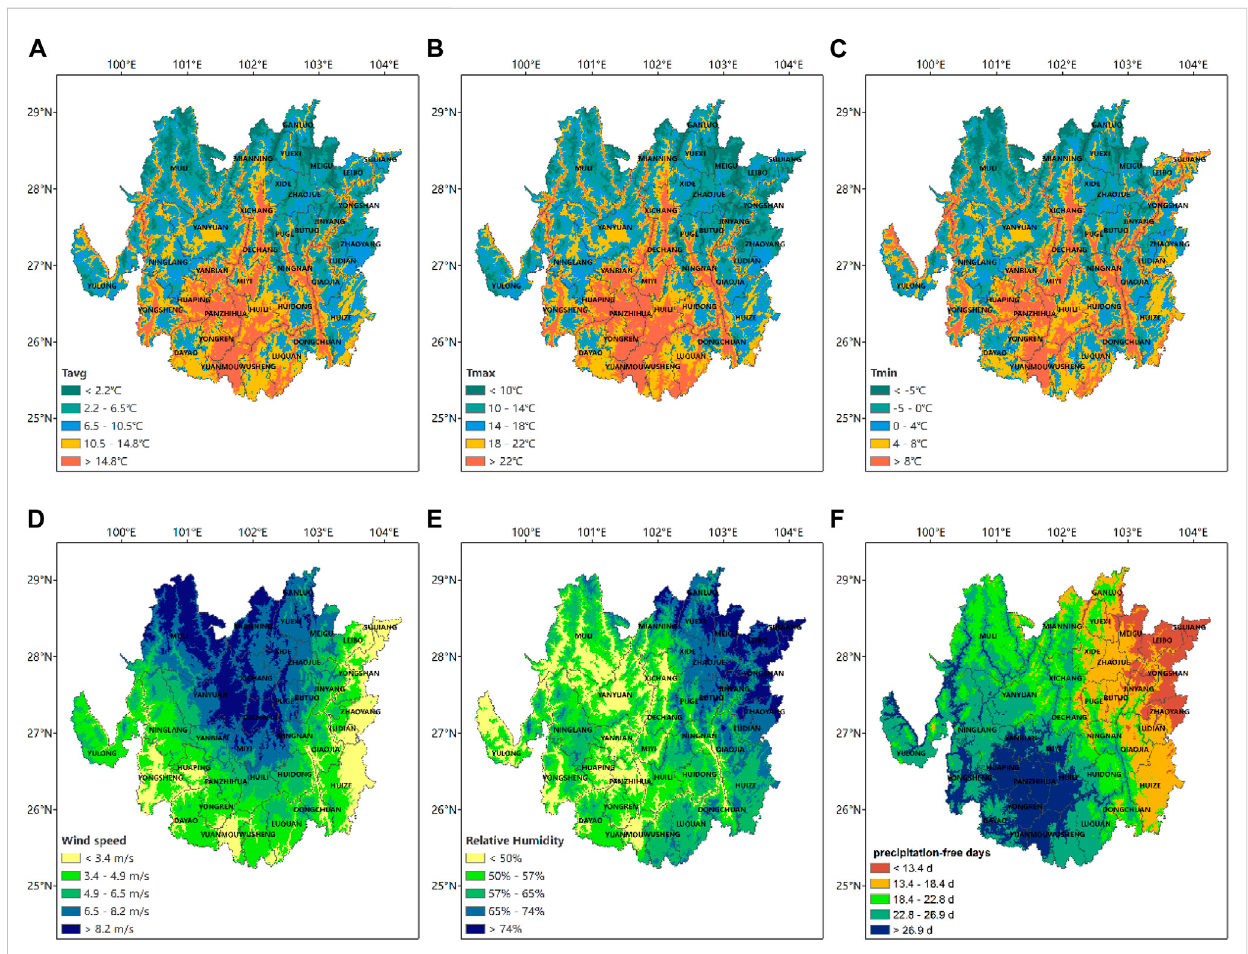
FIGURE 2 Spatial pattern of climate hazard factors in historical baseline (1981 – 2020) over high wild fi re incident area of southwestern China. (A) Ensemble means of daily temperature average. (B) Annual maximum of daily temperature maximum. (C) Annual minimum of daily humidity. (D) Wind speed. (E) Relative humidity. (F) Annual consecutive precipitation-free days